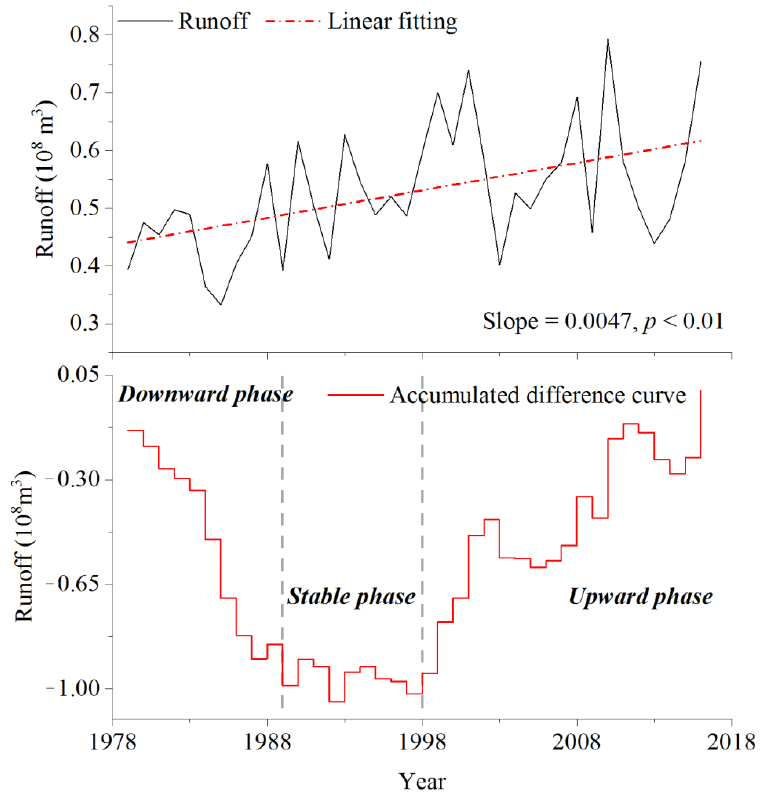
Figure 4. Variation of the annual runoff series in the Yushugou Basin from 1979 to 2016.